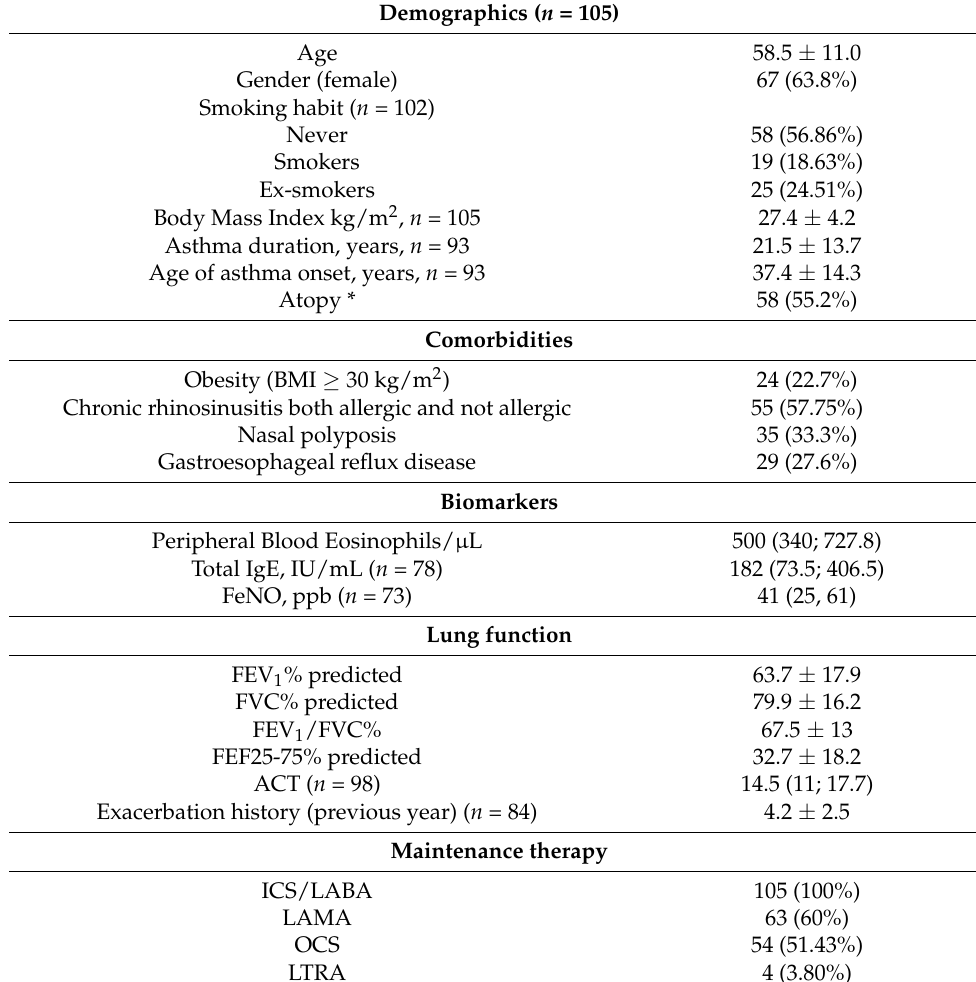
Table 1. Baseline characteristics of patients with severe eosinophilic asthma prior to mepolizumab